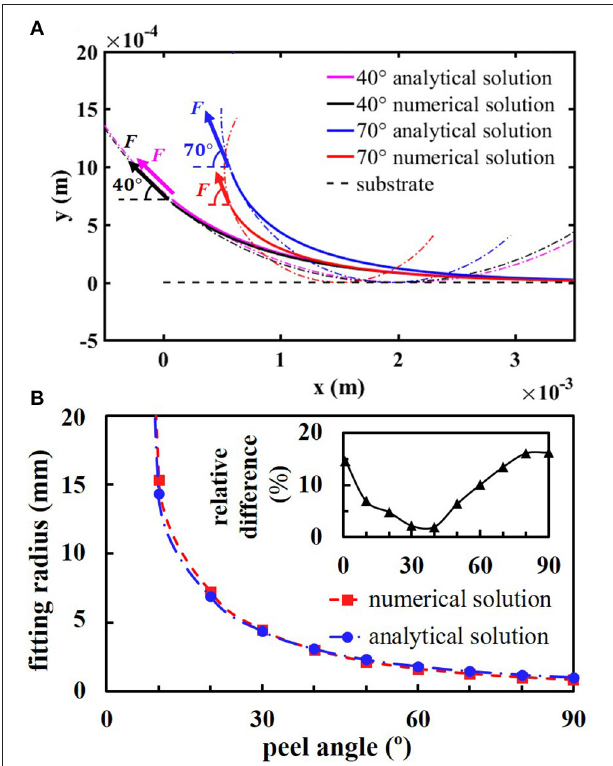
FIGURE 5 | The prediction of the shape of tape at different peeling angle. (A) The shapes of the curve of the peeling tape with the fitting curves of the peel zone at peel angles 40 and 70 ◦ , respectively. (B) The radius of the fitting circle predicted by the numerical solution and the approximate analytical solution, respectively. The insert is the relative difference.